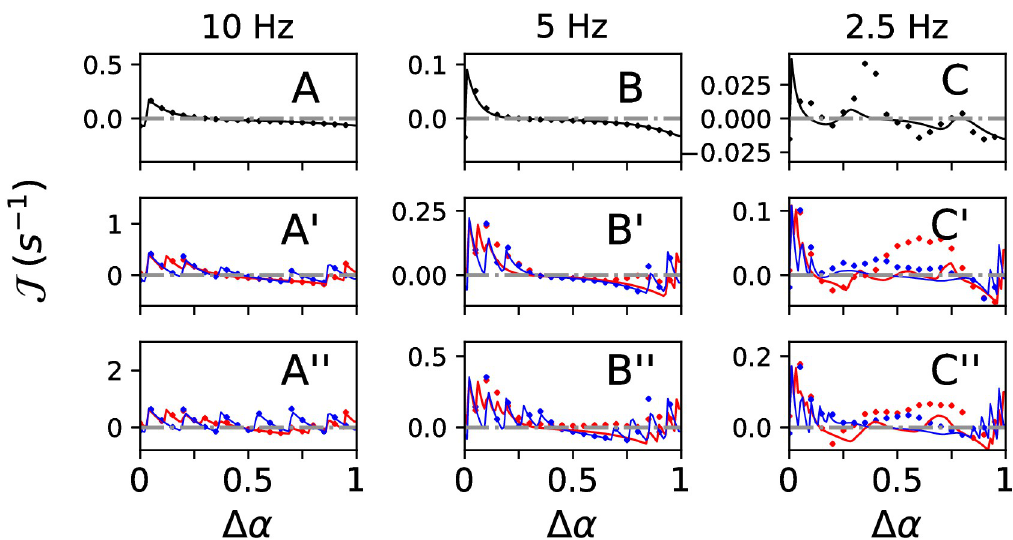
Fig 3. Effect of PMCS with ( M = 2) on the mean weight of synapses with postsynaptic neuron in subpopulation 2 and presynaptic neuron in subpopulation 1 as function of the phase lag, Δ α , between stimulus trains delivered to the two subpopulations. Panels show results for single-pulse (A-C) and burst stimuli with three (A’-C’) and five (A”-C”) pulses per burst. Results for high (120 Hz) and low (60 Hz) intraburst frequencies are shown in red and blue, respectively. Curves show theoretical approximations h J 1 i (Eq 19) and markers J est obtained from simulations and averaged over five network realizations and initial conditions (Methods). Parameters: d e = 1 and A stim = 0.4 (A,B,C), A stim = 0.8 (A’-C’, A”-C”). Note that different intervals are plotted on the